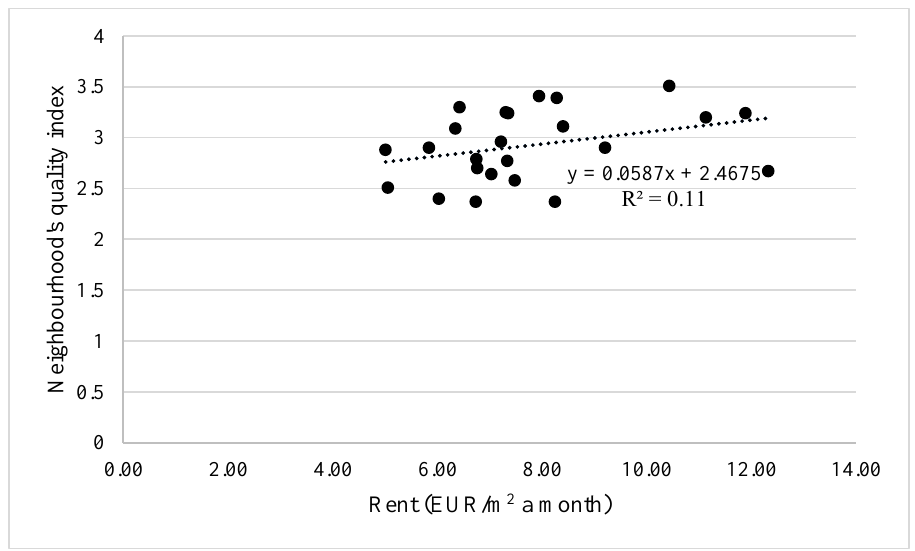
Fig. 2. Correlation between average rent per m 2 a month in EUR and neighbourhood quality